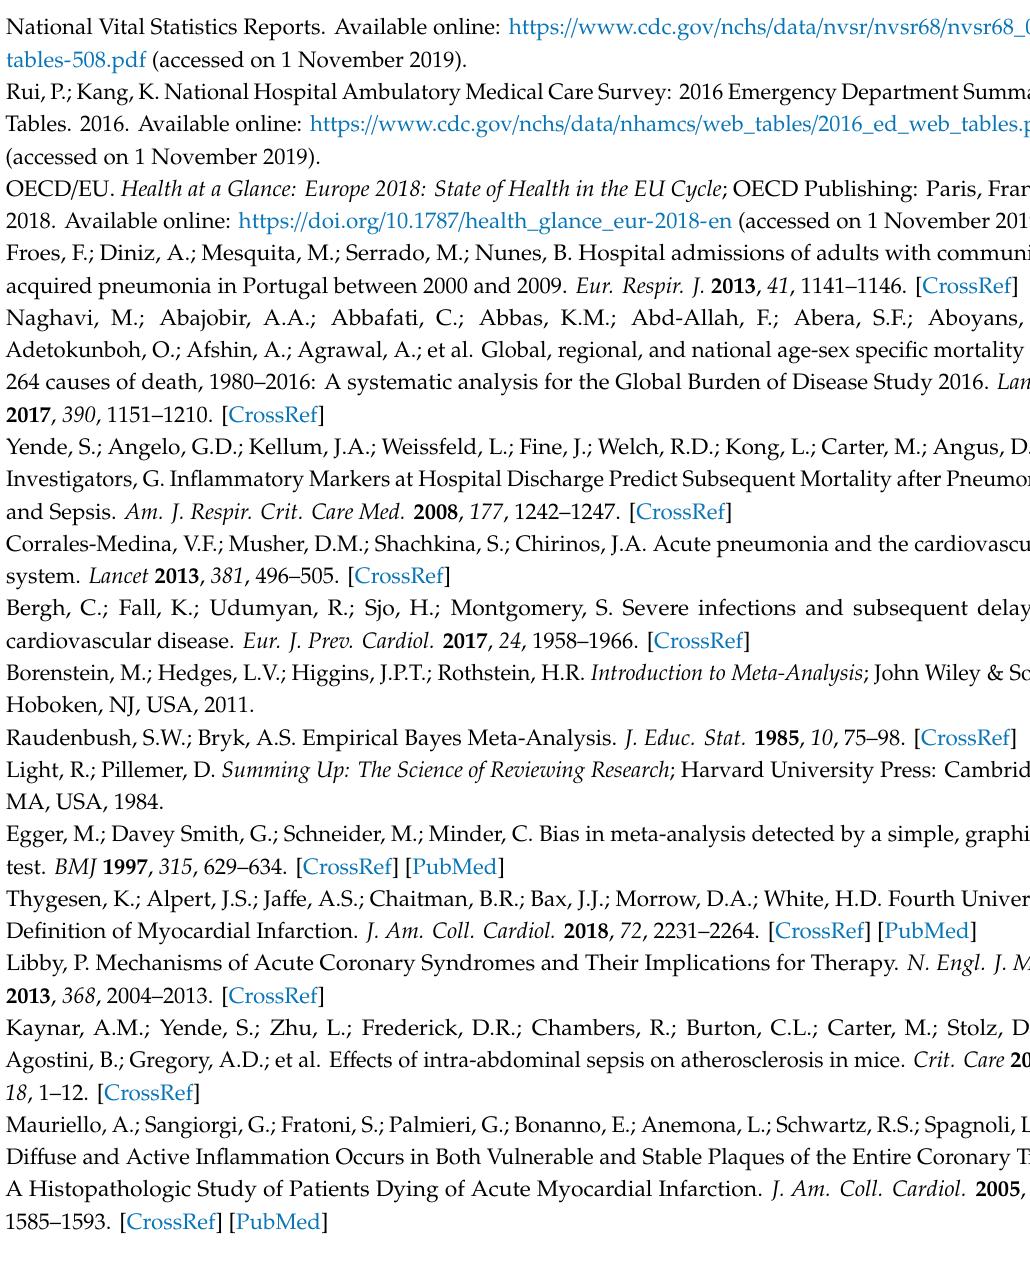
Table S1: PRISMA checklist; Table S2: Detailed characteristics of included studies; File S1: Funnel plot and Egger’s test for included studies of (a) overall cardiac complications, (b) ACS, (c) heart failure, (d) arrhythmias and (e) stroke after